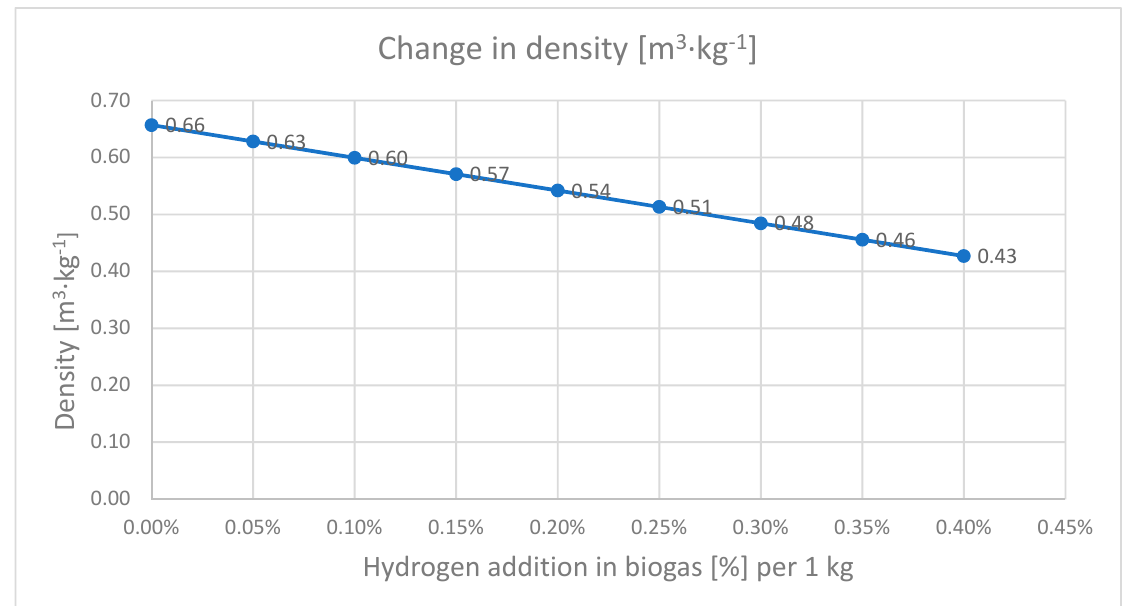
Figure 9. Change in gas volume as a function of hydrogen mass content .